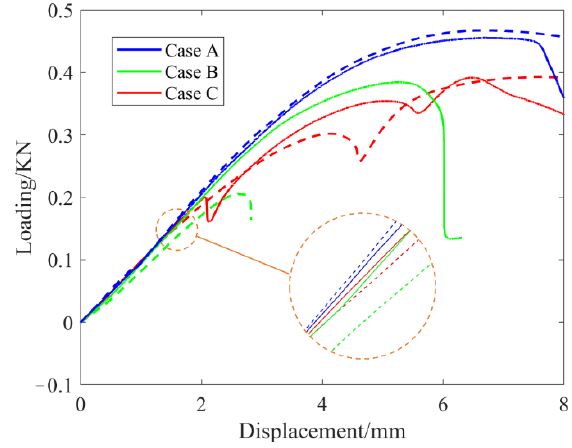
Figure 16. 3D printing and mechanical test results: ( a ) the 3D printed experimental specimens, and ( b ) the mechanical test setup.